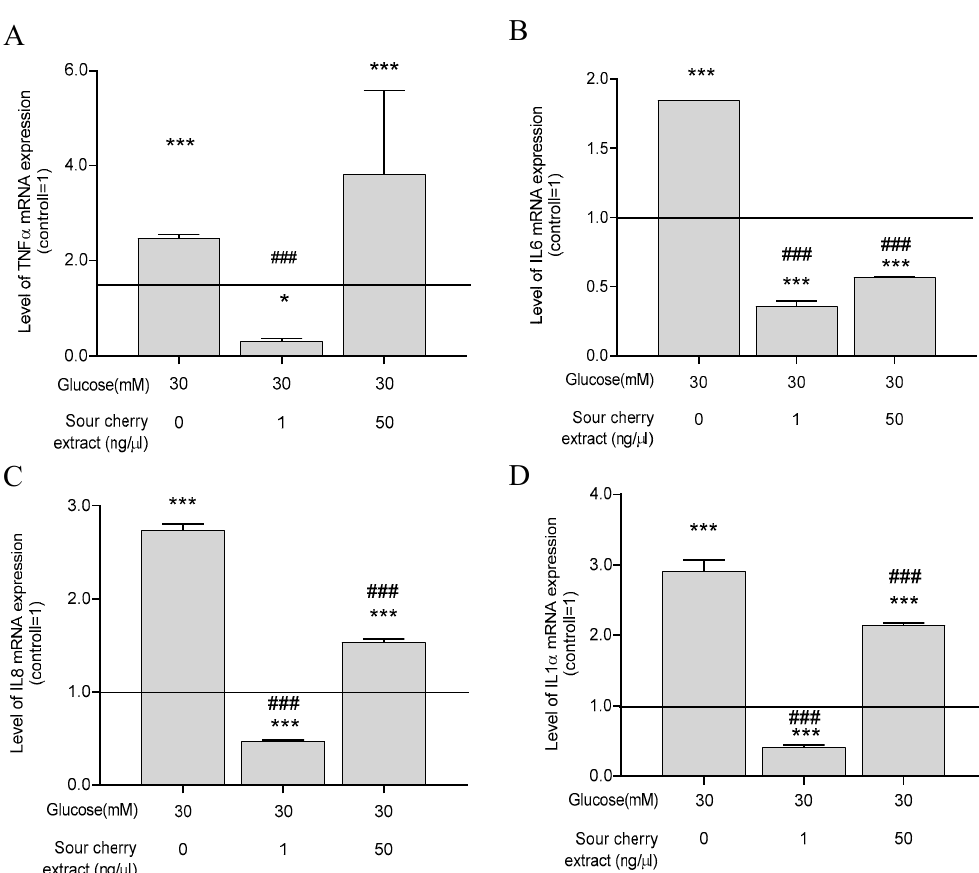
Figure 3. The anti-inflammatory action of anthocyanin-rich sour cherry extract. qPCR analyses of gene expression of tumor necrosis factor-alpha (TNF- α ) ( A ), interleukin-6 (IL-6) ( B ), interleukin-8 (IL-8) ( C ), and interleukin-1 α (IL-1 α ) ( D ) on HUVECs following the indicated seven days of simultaneous treatment. Data are presented using the ΔΔ CT method regarding glyceraldehyde-3-phosphate dehydrogenase (GAPDH)-normalized mRNA expressions of the untreated control (100%, solid line) with normoglycemia (5 mM) mean ± SD of two independent determinations. * and *** mark significant ( p < 0.05 and p < 0.001, respectively) differences as indicated compared to the untreated control with normoglycemia (5 mM). ### marks significant ( p < 0.001) differences as indicated compared to the untreated control with hyperglycemia (30 mM).